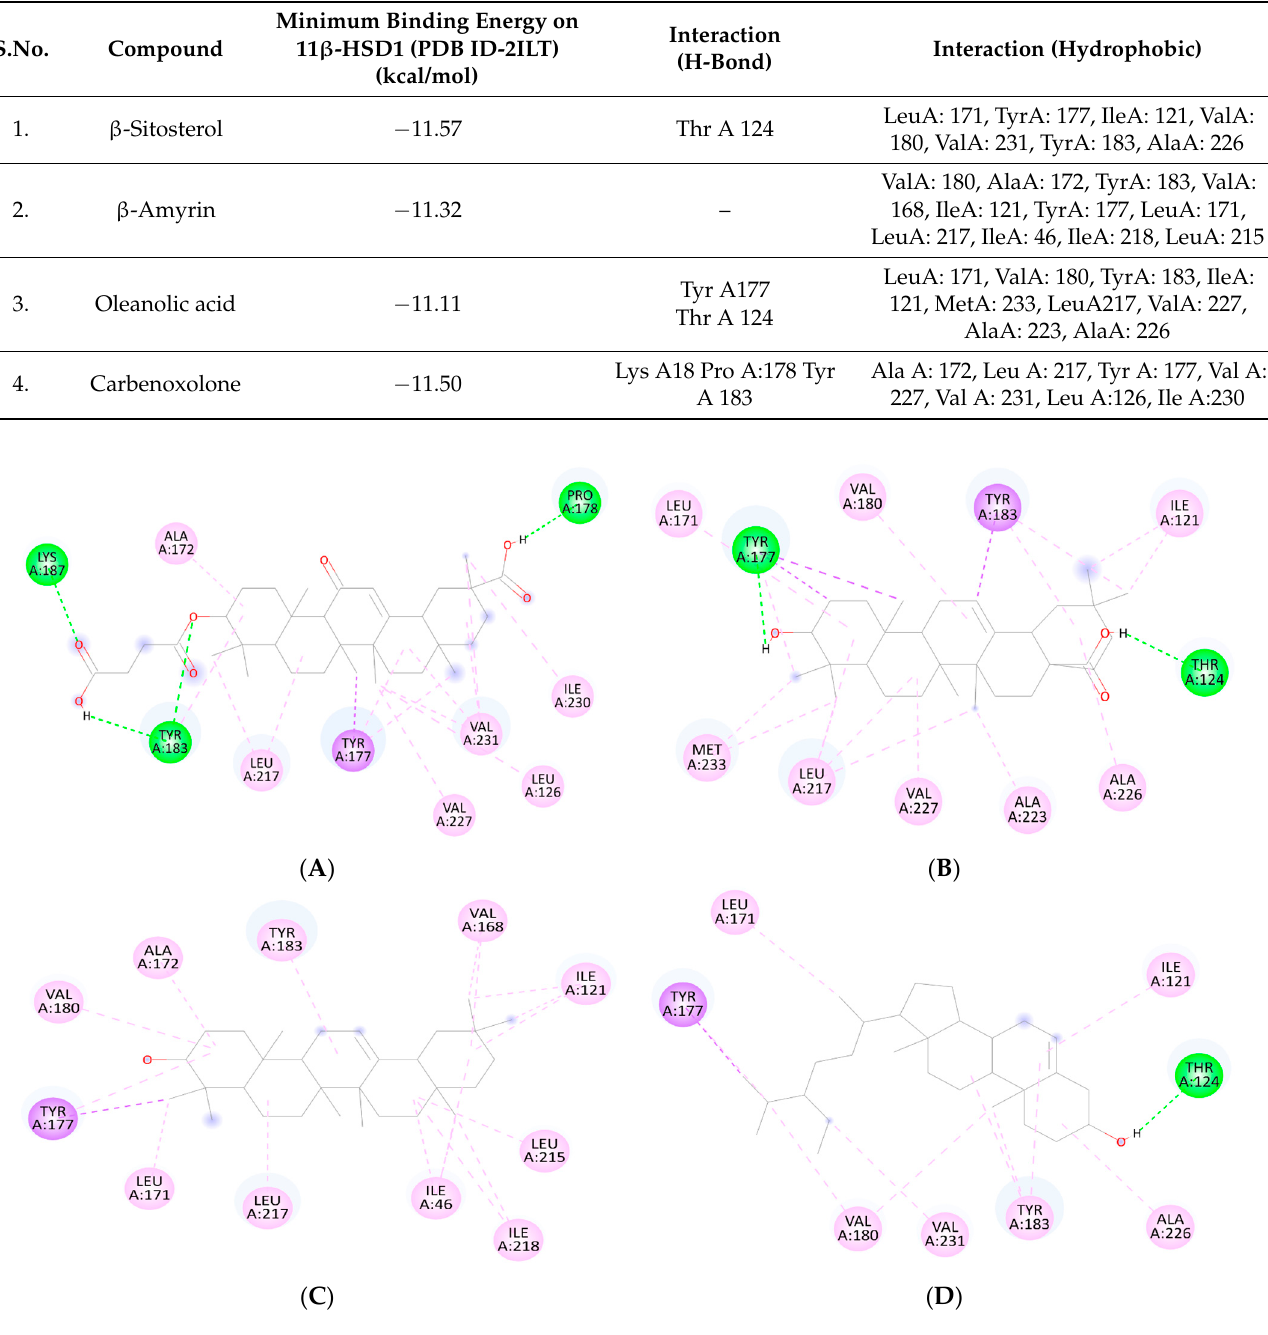
Figure 1. 2D Binding orientation in the docked complex of the ( A ) carbenoxolone Acid, ( B ) oleanolic acid, β -amyrin ( C ), and β -sitosterol with 11- β -HSD1 ( D ). The compound is represented in green. The image was generated using the Discovery Studio Visualizer.